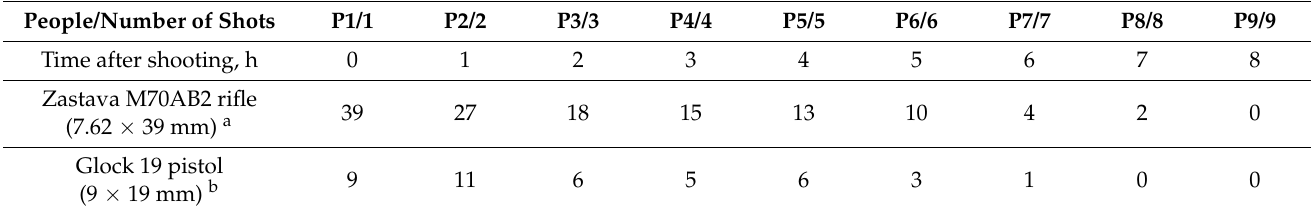
Table 7. Number of particles at different time intervals after shooting various numbers of shots with high- (Zastava M70AB2 rifle) and a low-caliber (Glock 19 pistol (9 × 19 mm)) firearms. The hands of the shooter were thoroughly cleaned before shooting. The sampling was performed at different time intervals.